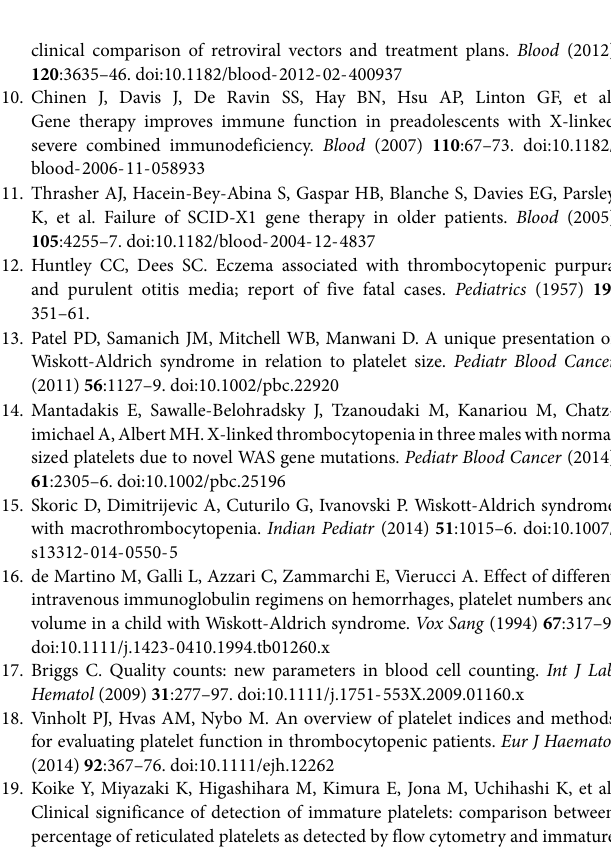
Table S1 | Complete data for the derivation cohort . NR, not reported; ND, not done. Table S2 | Blood draws with complete data for the derivation cohort . Table S3 | Complete data for the validation cohort . NR, not reported; ND, not done. Table S4 | Blood draws with complete data for the validation cohort